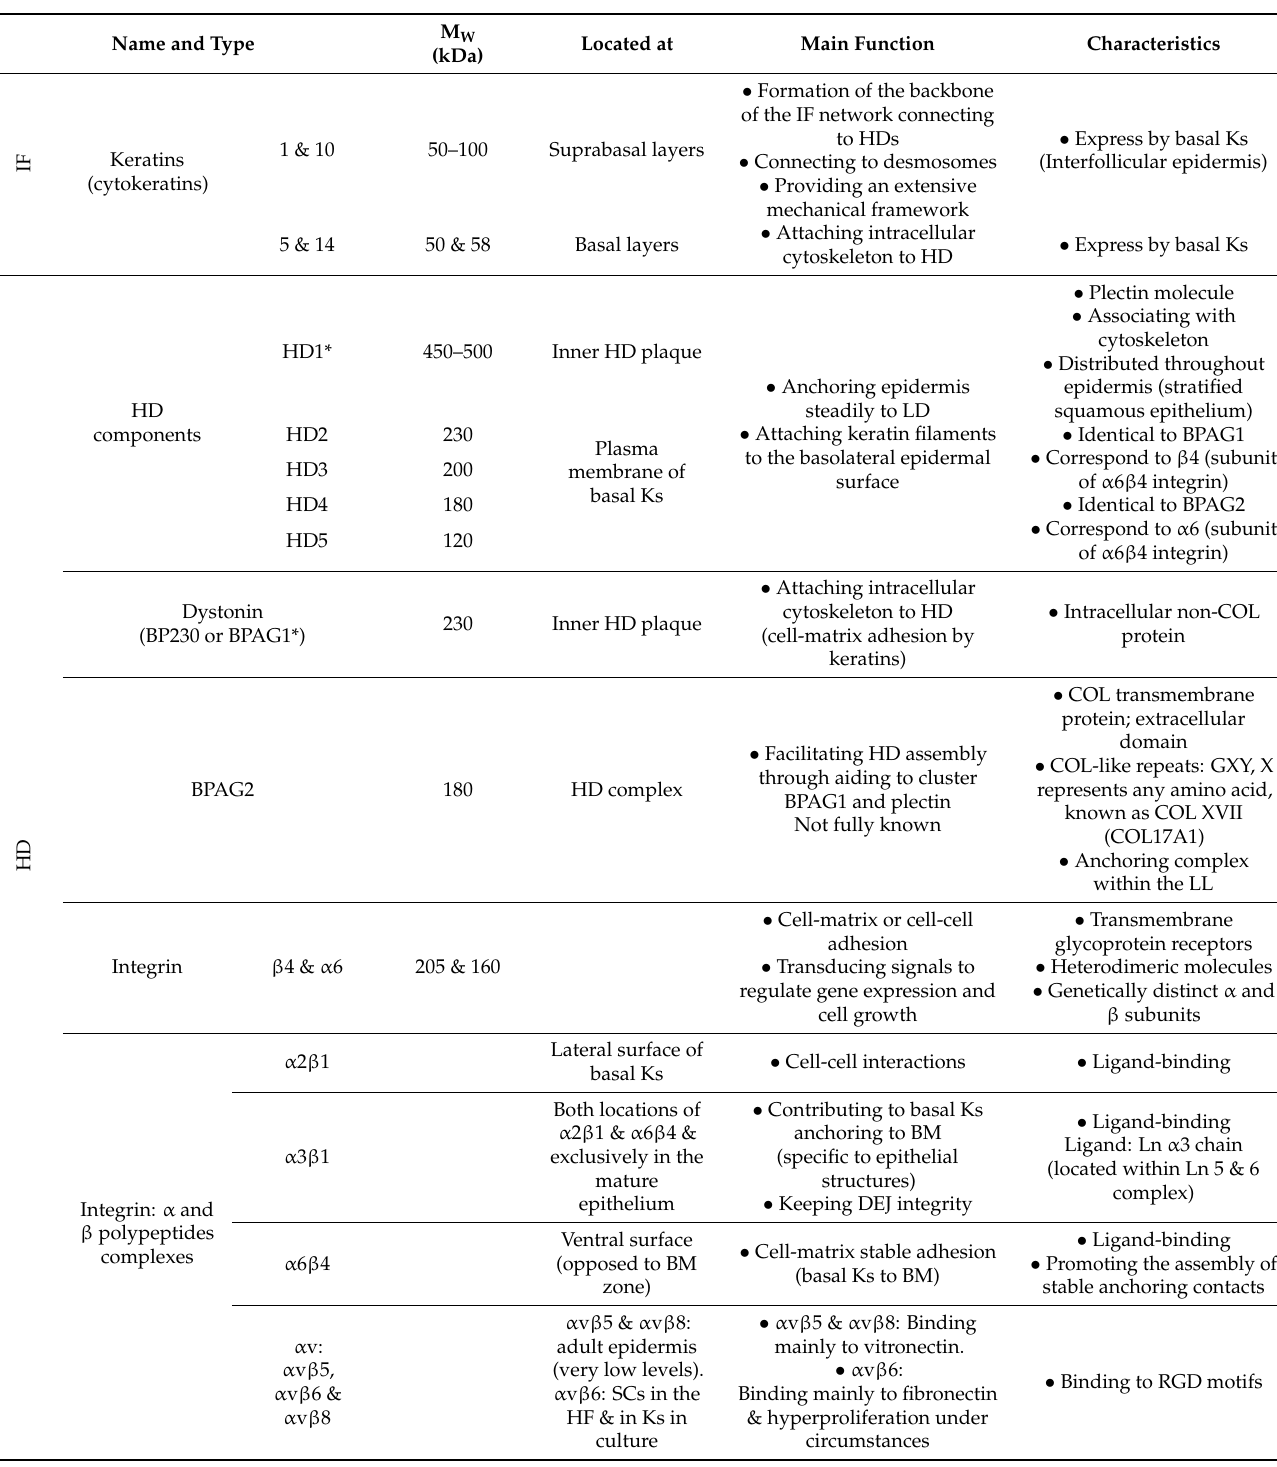
Table 1. The list of functional and essential proteins is responsible for the DEJ structural and signaling network. Abbrevia- tions : IF, Intermediate filament; HD, Hemidesmosome; AF, Anchoring filament; AP, Anchoring plaques; AFib, Anchoring fibrils; BPAG, Bullous pemphigoid antigen; LL, Lamina lucida; LD, Lamina densa; HF, Hair follicle; Ks, Keratinocytes; Fs,